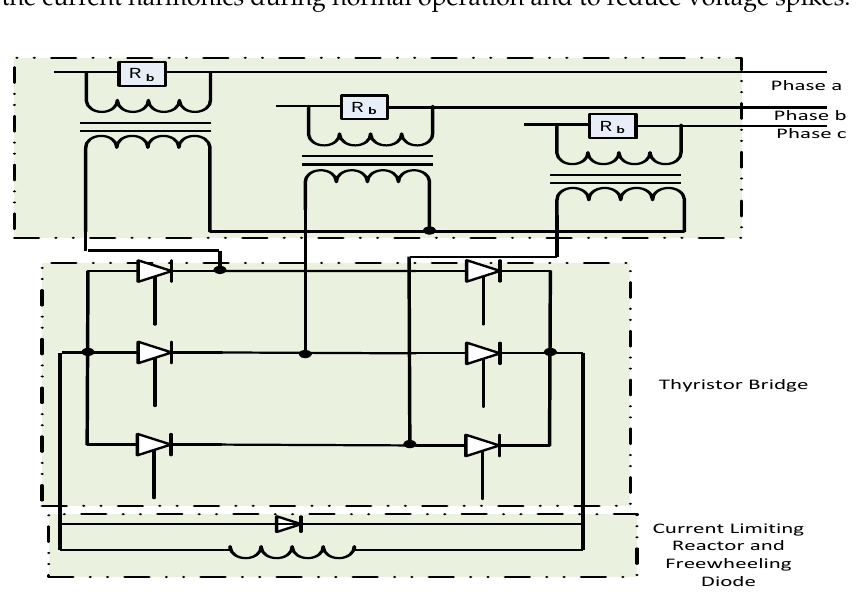
Needed 5. Optimal Parameters and Placement of Fault Current Limiters The optimal location for FCLs in a power network has several potential benefits. These include enhancing the system reliability and security, reducing fault current and voltage sag, improving fault ride through capability and increasing the interconnection of renewable energy. Several optimal placement techniques have been reported in the literature [14,18,23,106–113]. Number of FCLs units, optimal parameters and optimal positions are considered for the placement of the FCLs in power system with several objectives like fault current reduction, reliability and stability improvement, FCL cost reduction and optimization of operating time of the over current relays. Some of the works focused on optimal placement mainly with single objective function as either fault current reduction [114,115] or stability enhancement [113]. Since there is the tradeoff among several objectives, enhancing one of them might lead to the deterioration of the others. Multiobjective optimization techniques [18,23,107,116] have been reported to solve the above mentioned problem. However, most of the optimal placement techniques do not take into account uncertainties in power systems, especially the unpredictable variations in the status of a DG, wind and PV systems when determining the best location for SFCL [14]. New placement algorithms can be developed considering several networks uncertainties for better performance. Table 4 summarizes optimal placement parameter selection techniques for different superconducting FCLs.